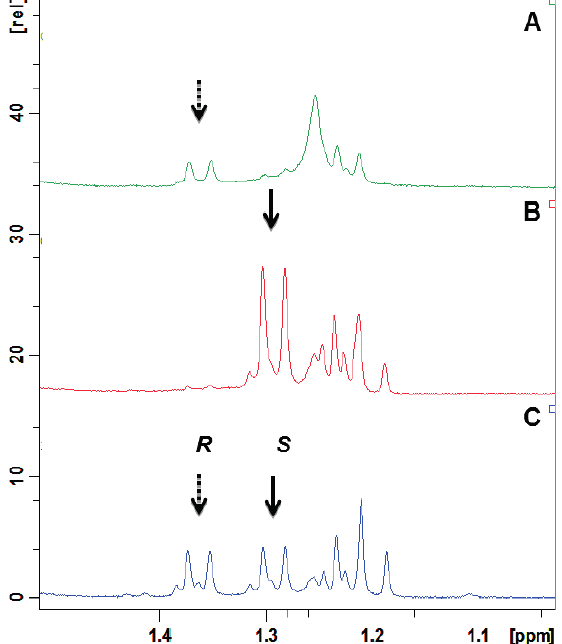
Figure 3. 1 H NMR spectra of ( S )-( − )-MTPA esters with: ( A ) a mixture enriched with the alcohol ( R )- 2 obtained by biotransformation of 3 with A. niger ; ( B ) a mixture enriched with the alcohol ( S )- 2 obtained by biotransformation of 3 with P. citrinum ; and ( C ) rac - 2 .